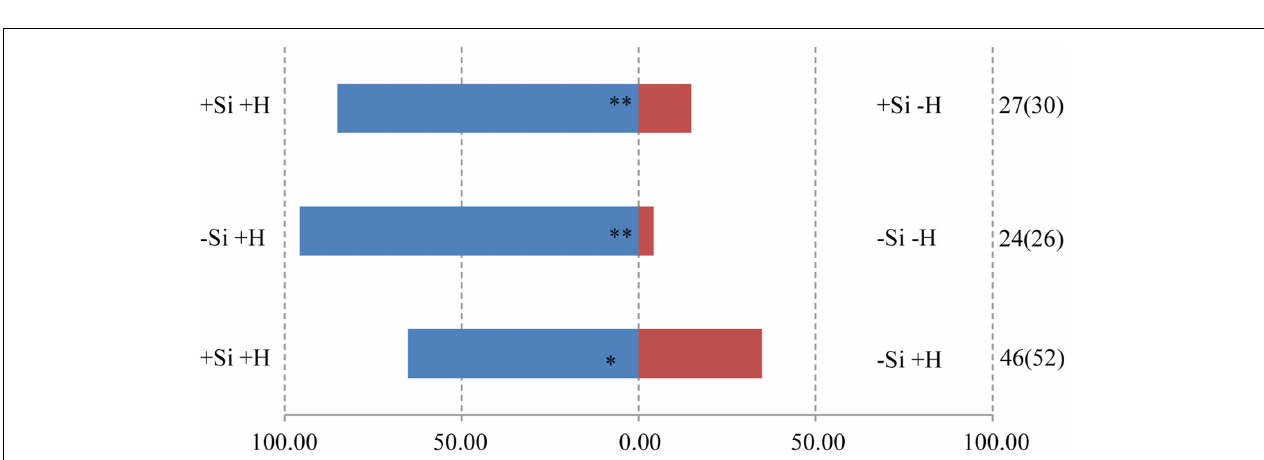
FIGURE 3 | Y-tube olfactometer response of the parasitic wasp, T. flavo-orbitalis to volatile profiles of WT rice plants, showing the effect of herbivore (H) ( C. medinalis ) infestation and silicon (Si) treatment. Asterisks indicate significant difference from a 50:50 distribution (Chi-square test; ∗ P < 0.05; ∗∗ P < 0.01; n , number of wasp individuals responding to odor source, number in parentheses means the number of wasp individuals used for test). (Statistic comparison, +Si +H vs. +Si –H, χ 2 = 8.000, P = 0.005; –Si +H vs. –Si –H, χ 2 = 5.762, P = 0.016; +Si +H vs. –Si +H, χ 2 = 8.533, P = 0.003). % parasitic wasps to plant odour source.